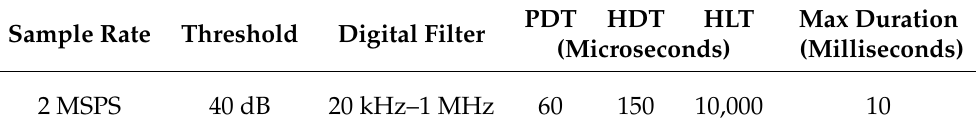
Table 1. The used measurement variable values of the signal collector: sample rate, threshold value, digital filter frequency, PDT, HDT, HLT, and max duration